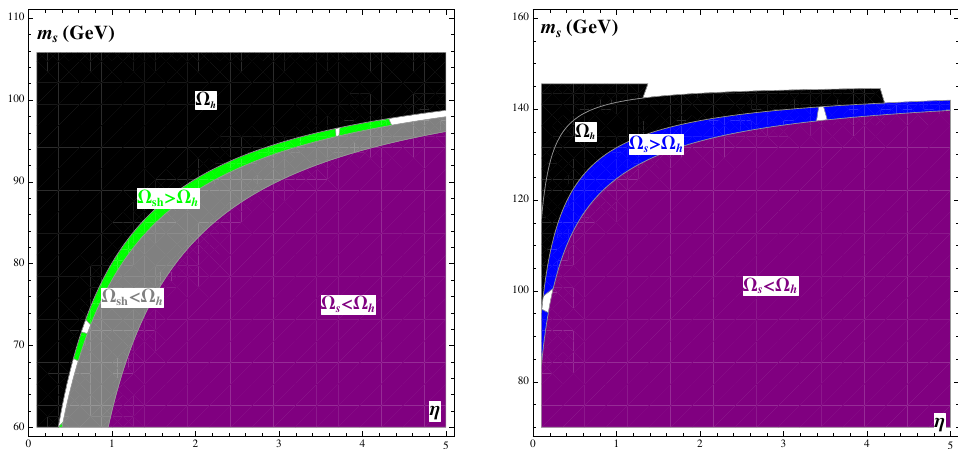
Figure 3 . Tree level vacuum structures at zero temperature on the ( (cid:17); m s ) plane for the case (cid:17) > 0: (Left panel) a smaller (cid:21) sh = 0 : 37 with (cid:21) s = 1; (Right panel) a larger (cid:21) sh = 0 : 7 with (cid:21) s =